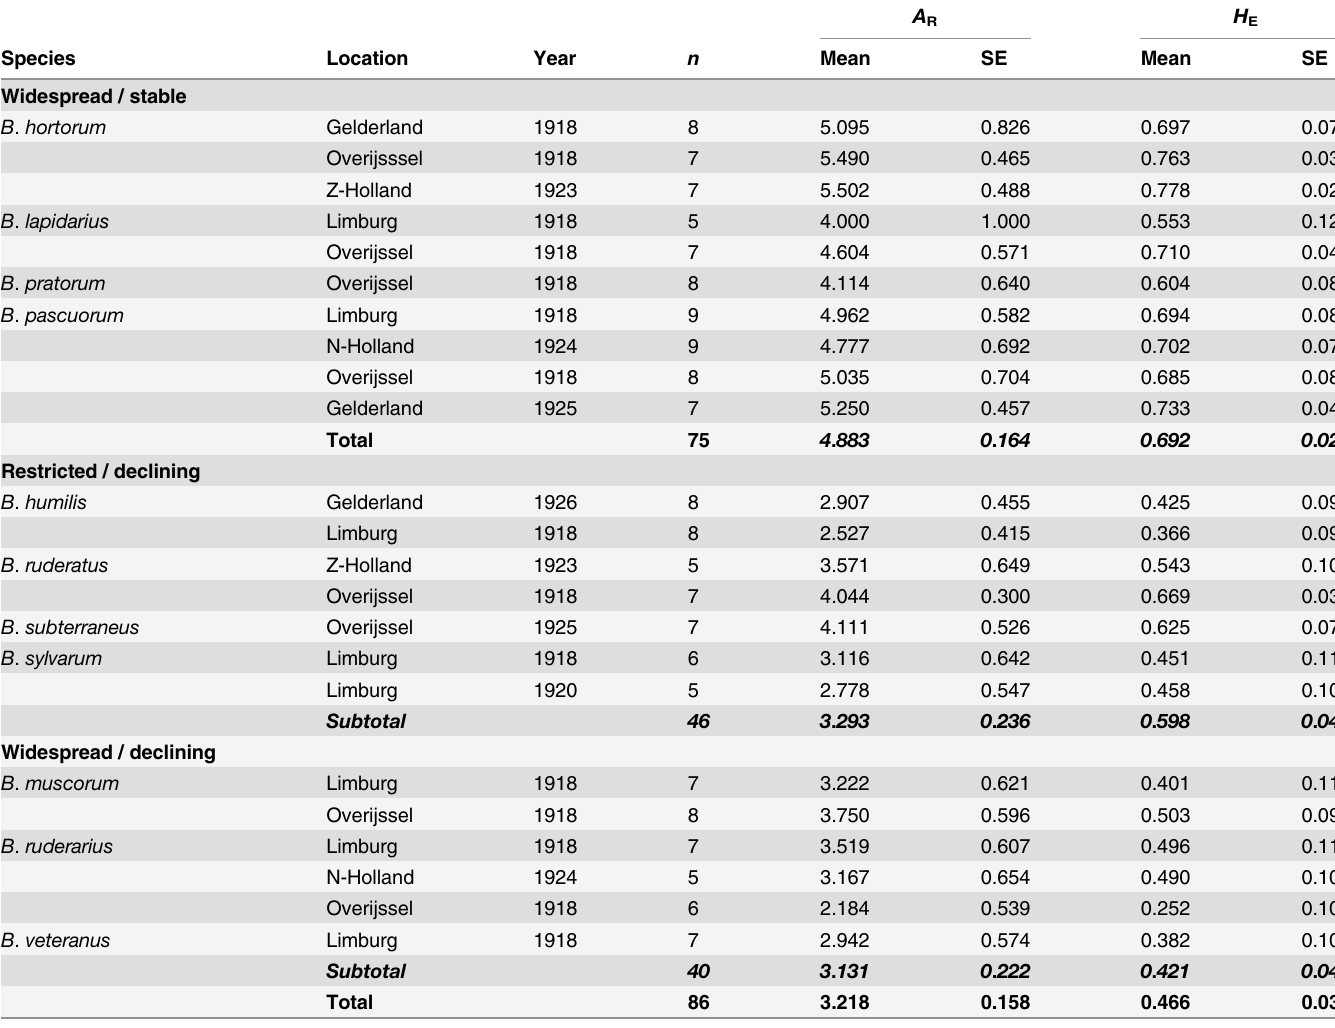
Table 2. Historical genetic diversity within all Bombus